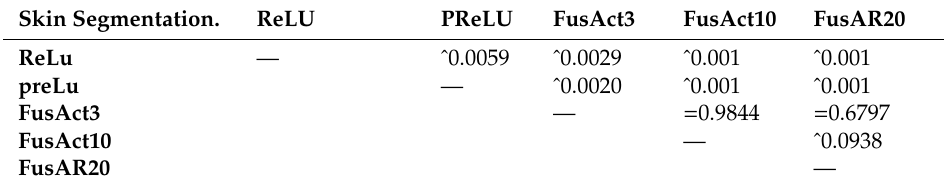
Table 7. P-value of the comparison among some tested approaches in the medical image classification experiment ( < denotes that the method in row wins, ˆ denotes that the method in column wins, = denotes that there are were no statistically significant di ff erences). Classification ReLU wMeLU(255) FusRan3(255) FusRan10(255) FusRan20 ReLu — ˆ0.0046 ˆ0.0210 ˆ0.002 ˆ0.002 wMeLu(255) — ˆ0.0024 ˆ0.004 ˆ0.002 FusRan3(255) — ˆ0.004 ˆ0.002 FusRan10(255) — = 0.7148 FusRan20 — Table 8. P-value of the comparison among some tested approaches in the skin segmentation experiment. Skin Segmentation. ReLU PReLU FusAct3 FusAct10 FusAR20 ReLu — ˆ0.0059 ˆ0.0029 ˆ0.001 ˆ0.001 preLu — ˆ0.0020 ˆ0.001 ˆ0.001 FusAct3 — = 0.9844 = 0.6797 FusAct10 — ˆ0.0938 FusAR20